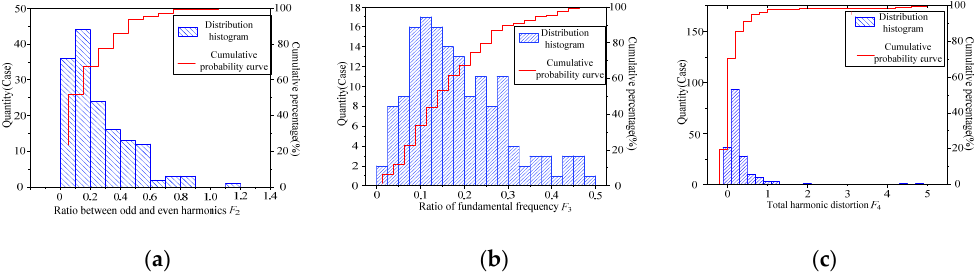
Figure 10. Distribution histogram and cumulative probability curve of transformer acoustic typical eigenvalues. ( a ) Ratio between odd and even harmonics F 2 . ( b ) Ratio of fundamental frequency F 3 . ( c ) Total harmonic distortion F 4 .